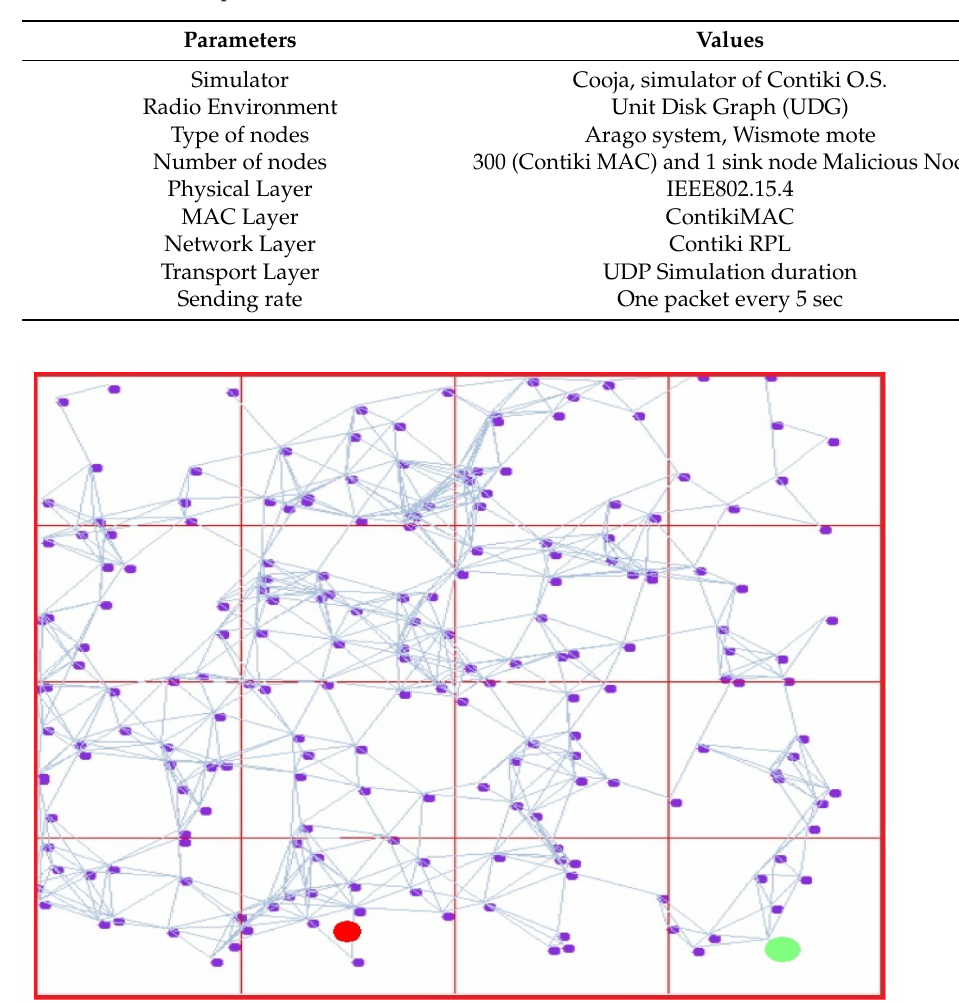
Figure 7. Simulation